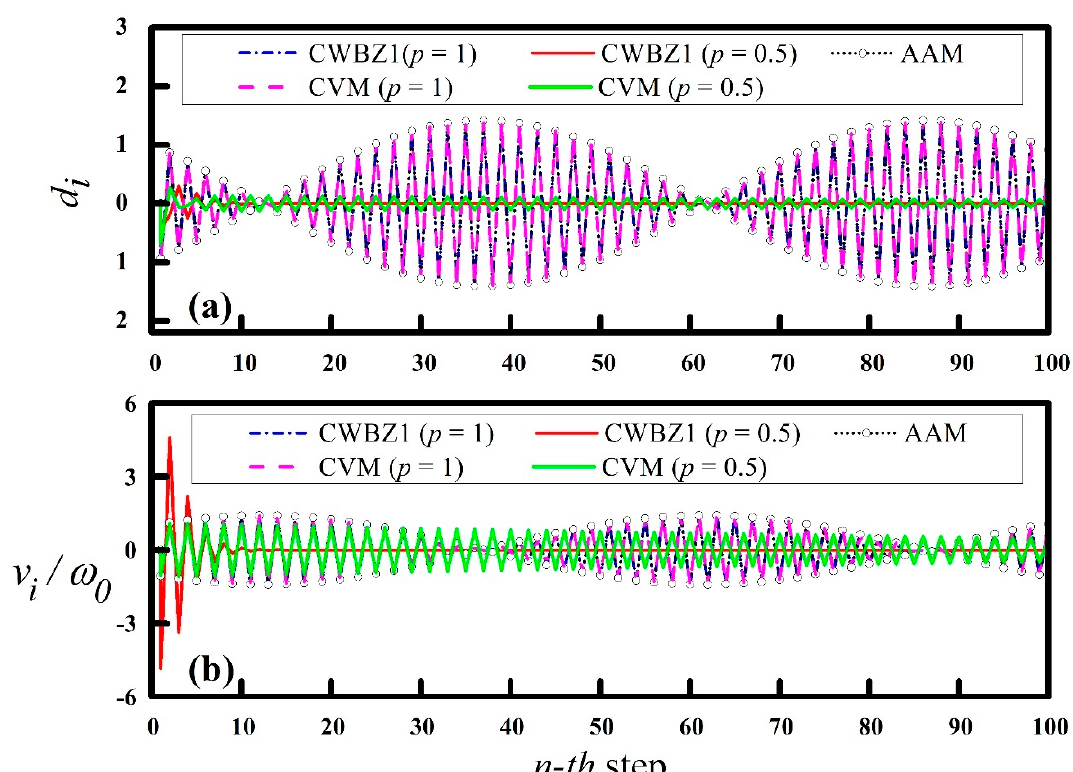
Figure 6. Comparison of the overshoot response of CVM for the second initial conditions.